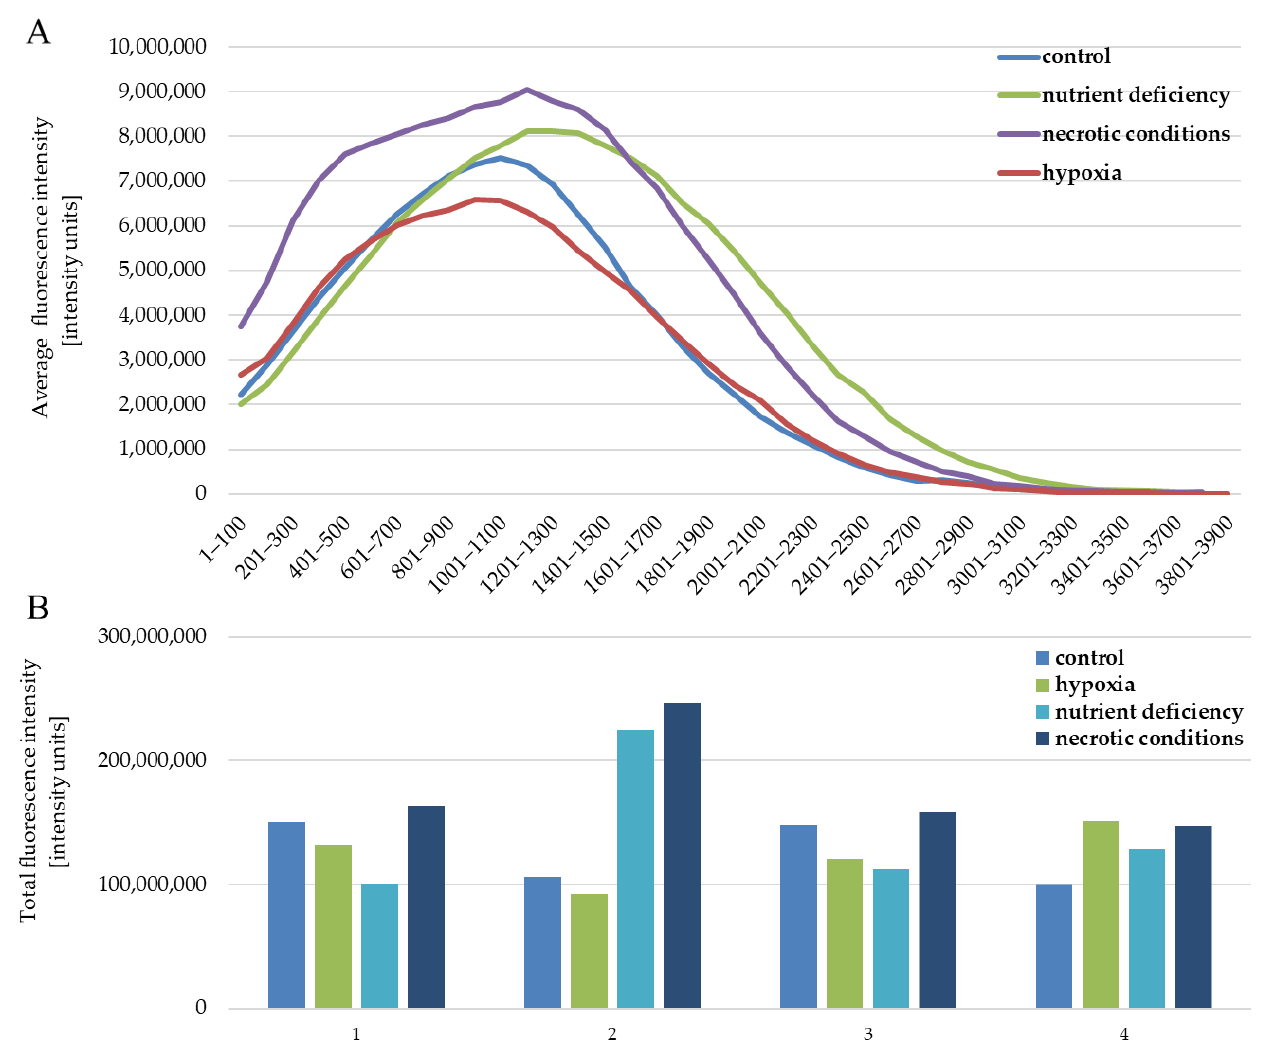
Figure 5. Fluorescence intensity reflecting the expression level of the AR protein in U87 cells cul- tured under the following conditions: control, nutrient deficiency, hypoxia, and necrotic conditions. ( A ) shows the distribution of intensity levels. ( B ) shows the sum of the intensity in a given image, separately for (1 – 4) repetitions for each of the tested conditions.